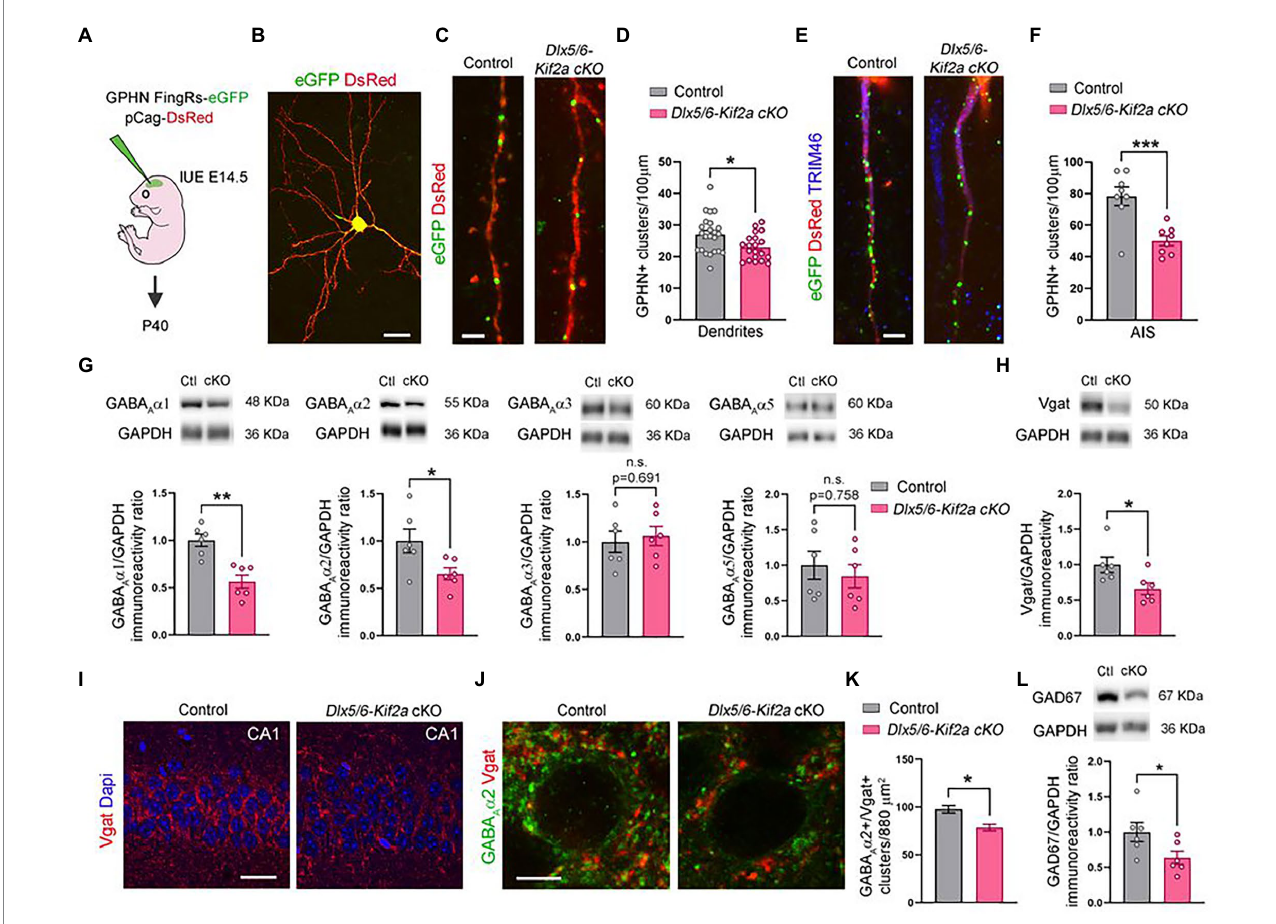
FIGURE 5 Deletion of KIF2A affects inhibitory signaling in cortex and hippocampus. (A) Experimental design of in utero (IUE) experiments. (B) Control pyramidal neuron electroporated at E14.5 with DsRed and gephyrin (GPHN) FingRs-eGFP plasmids and analyzed at P40. (C) High magnification of dendrites showing gephyrin-positive clusters (eGFP signal) in the indicated genotype. (D) Quantification of gephyrin positive (GPHN+) clusters density in dendrites (control: 27.02 ± 1.23 clusters/100 μ m, n = 23 from 3 mice; Dlx5/6-Kif2a cKO : 22.99 ± 0.92 cluster/100 μ m n = 20 from 2 mice). (E) Axon initial segment (AIS) showing gephyrin-positive clusters (eGFP) in indicated genotypes. (F) Quantification of gephyrin positive (GPHN+) clusters density in the AIS (control: 78.28 ± 5.94 cluster/100 μ m, n = 8 from 3 mice; Dlx5/6-Kif2a cKO : 50.15 ± 3.14 cluster/100 μ m n = 8 from 2 mice). (G) Western blot analysis and quantification of the relative amount of different GABA A receptor subunits in P40 cortical and hippocampal extracts of control (Ctl) and Dlx5/6-Kif2a cKO (cKO) mice ( n = 6 for each genotype). (H) Western blot analysis and quantification of the relative amount of Vgat in P40 cortical and hippocampal extracts (n = 6 for each genotype). (I,J) Immunofluorescence for Vgat (I) and GABAA α 2 and Vgat (J) in the CA1 pyramidal layer at P40. (K) Quantification of GABA A α 2+/Vgat+ cluster density in the CA1 pyramidal layer of hippocampus (control: 97.78 ± 3.82, n = 3 mice; Dlx5/6-Kif2a cKO : 78.61 ± 3.48, n = 3 mice). (L) Western blot analysis and quantification of the relative amount of GAD67 in P40 cortical and hippocampal extracts ( n = 6 for each genotype). Scale bars (B) 20 μ m, (C,E) 2.5 μ